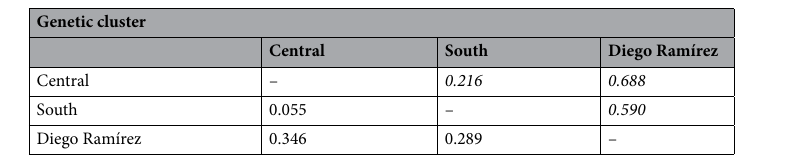
Table 5. Pairwise G-statistics for the three main genetic clusters of Aphrastura populations identified (see “Methods” for details). Values below the diagonal correspond to the Nei’s standardized index G ′ ST(Nei) , while values above the diagonal (italics) were calculated using Hedrick’s standardized index corrected for small samples G ″ ST . The true G ST value is supposed to lie in between the two indexes 71 . All p values < 0.001 (based on 1000 permutations).